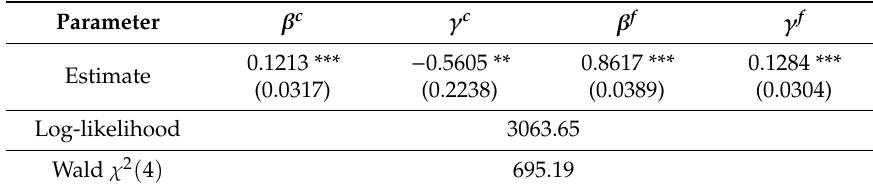
Table 2. The estimation results of the state